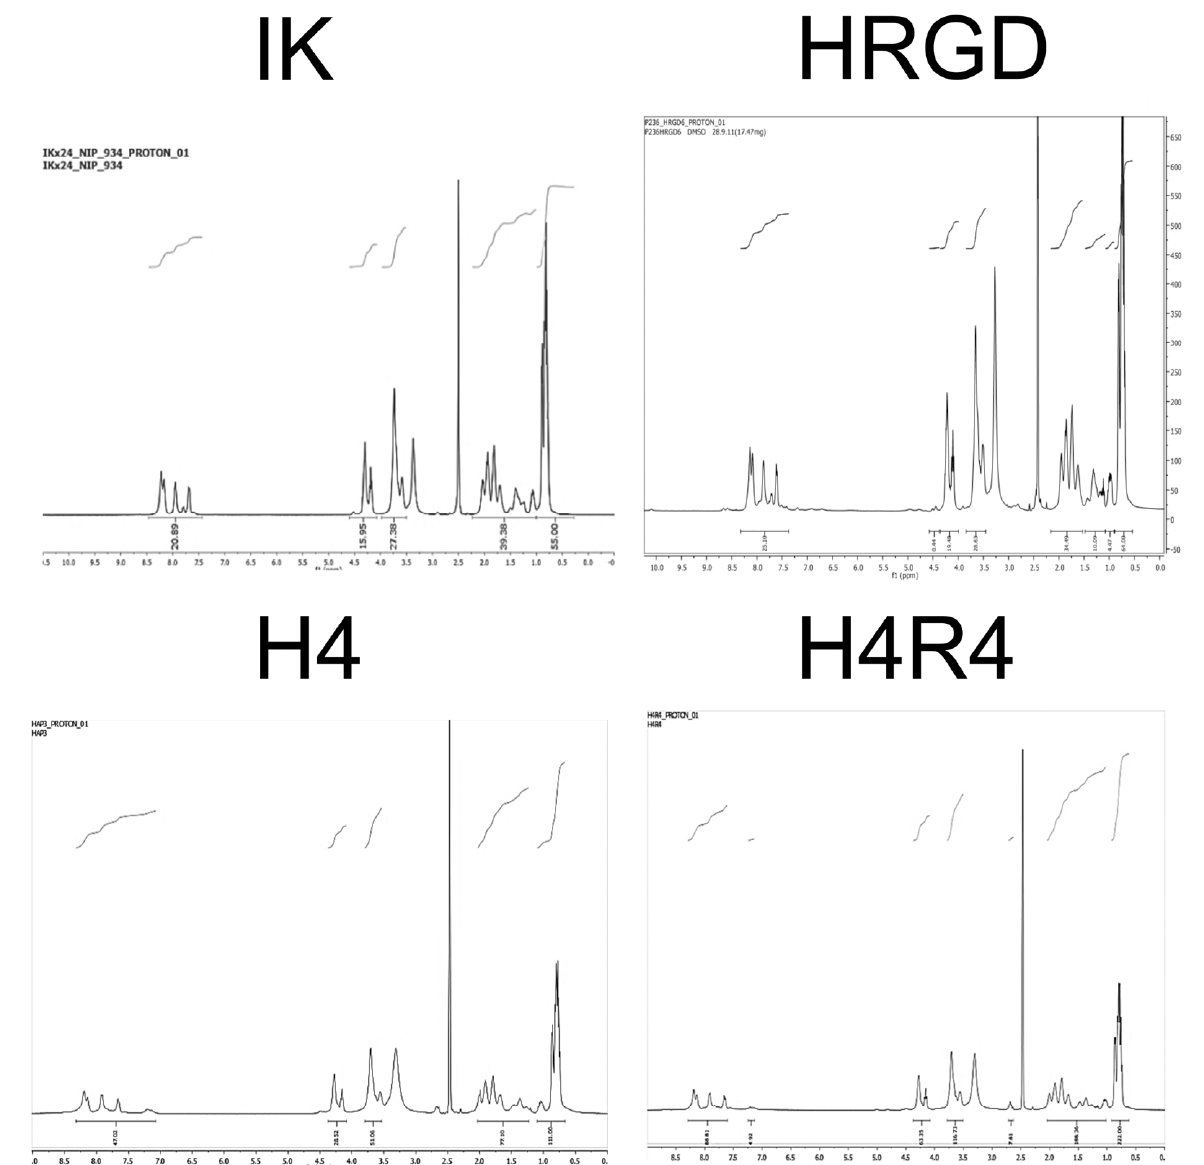
Figure 4. Proton NMR spectra of the purified ELRs.